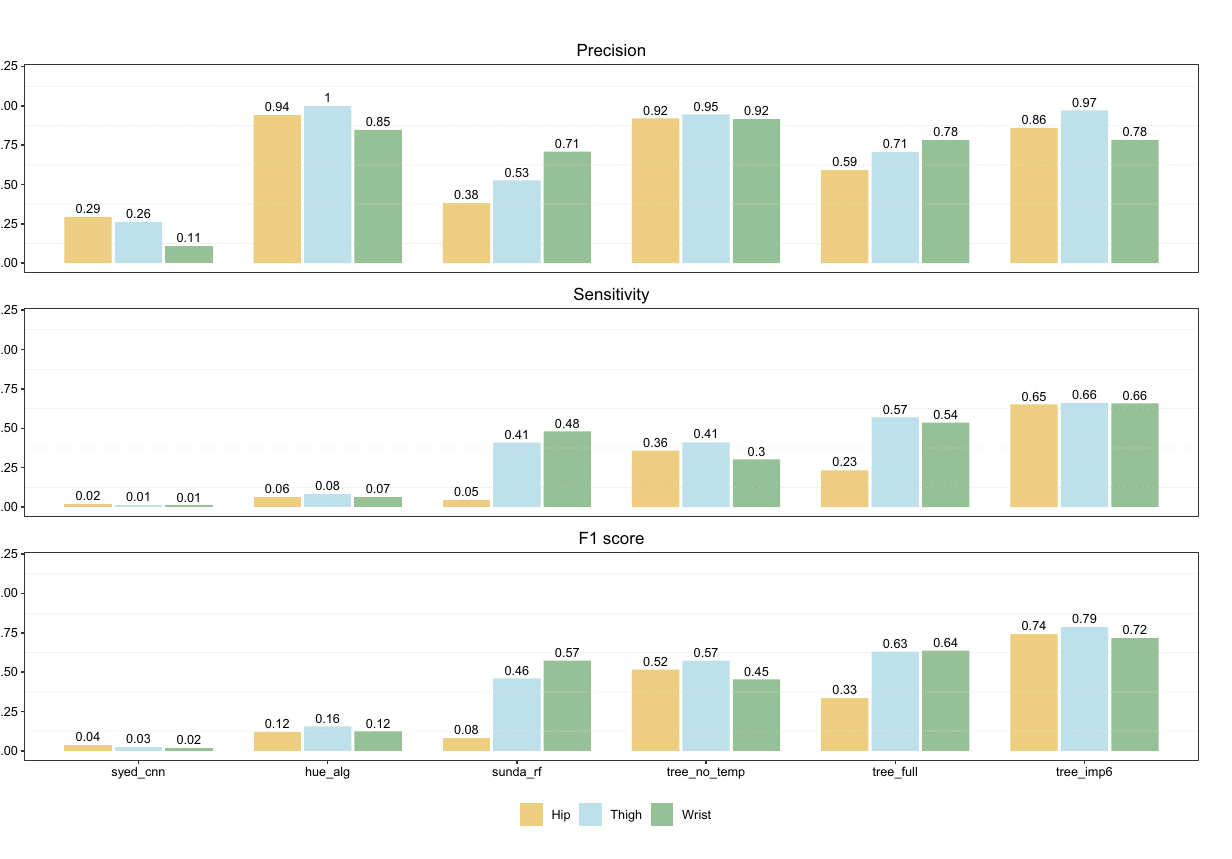
Figure 6. Classification performance for episodes no longer than 60 min in length. Metrics are shown for the three different gold-standard dataset including hip-worn, thigh-worn, and wrist-worn raw accelerometer